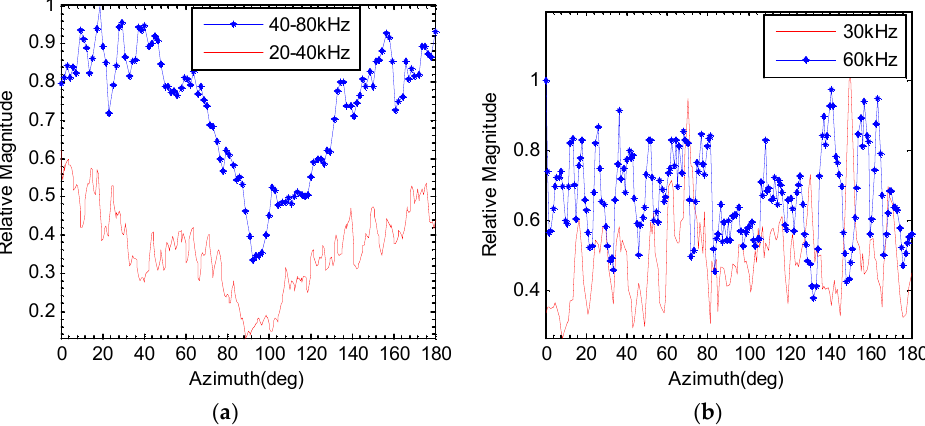
Figure 12. STD of echo envelope fluctuation intensity with different frequencies, the pulse length is 3 ms. ( a ) STD comparison of wideband echo envelope fluctuation intensity with different frequencies; ( b ) STD comparison of CW echo envelope fluctuation intensity with different frequencies.